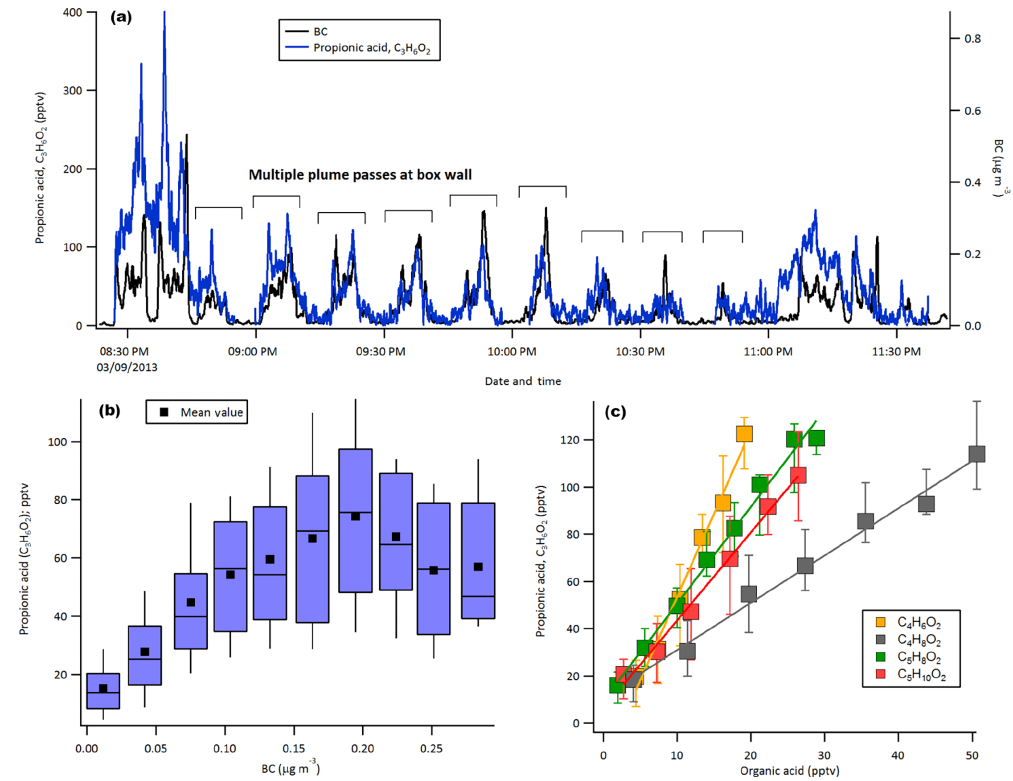
Figure 2. (a) Time series of measured propionic acid and BC during Flight 18 (Syncrude – ML). Multiple plume intercepts at the virtual box wall are shown. (b) Correlation between propionic acid and BC during F18. Black data points represent the means, and blue boxes and whiskers are the 25th to 75th percentiles and 90th and 10th percentiles respectively. (c) Correlations between various measured organic acids during F18. Error bars represent the 25th to 75th percentiles of the